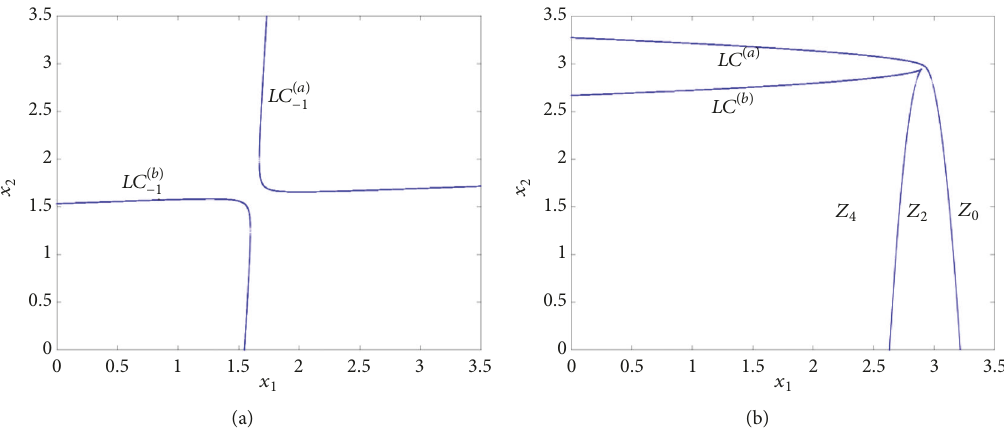
Figure 12: (a) The sketch of 𝐿𝐶 −1 with 𝑎 = 1.95 , 𝑏 = 0.044 , 𝑐 = 1.58 , 𝛽 = 0.9 , 𝛾 = 0.77 , 𝛼 1 = 1.57 , and 𝛼 2 = 1.625 . (b) Critical curves ) . The curve 𝐿𝐶 (𝑎) separates 𝑍 𝐿𝐶 = 𝑇(𝐿𝐶 −1